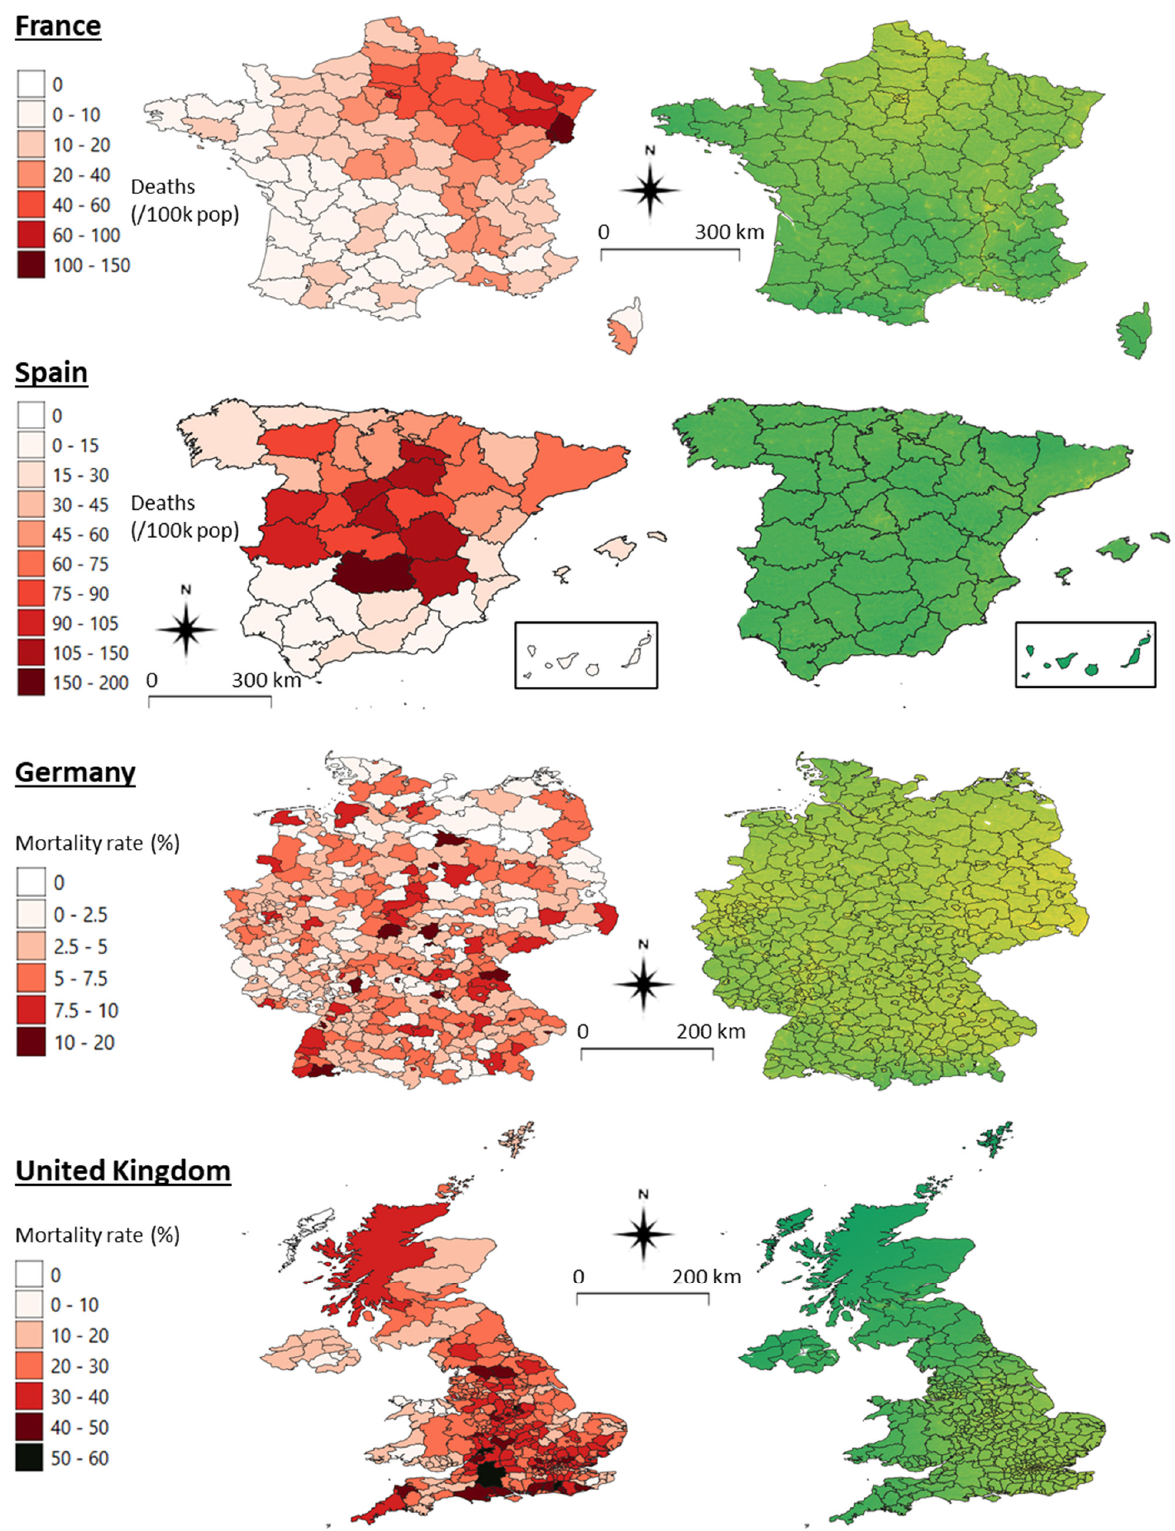
Figure 1. Map comparisons of satellite-derived PM 2.5 distributions and COVID-19 infections, deaths (per 100,000 inhabitants), or mortality rates (deaths/infections) in eight countries (see Table 1 for information about dates and data sources). Maps of different countries may not be compared directly due to different classification schemes and spatial scales. Some administrative units’ boundaries were adapted according to the COVID-19 data available (e.g., merged districts of Galicia, Catalunia, and Pais Vasco in Spain).